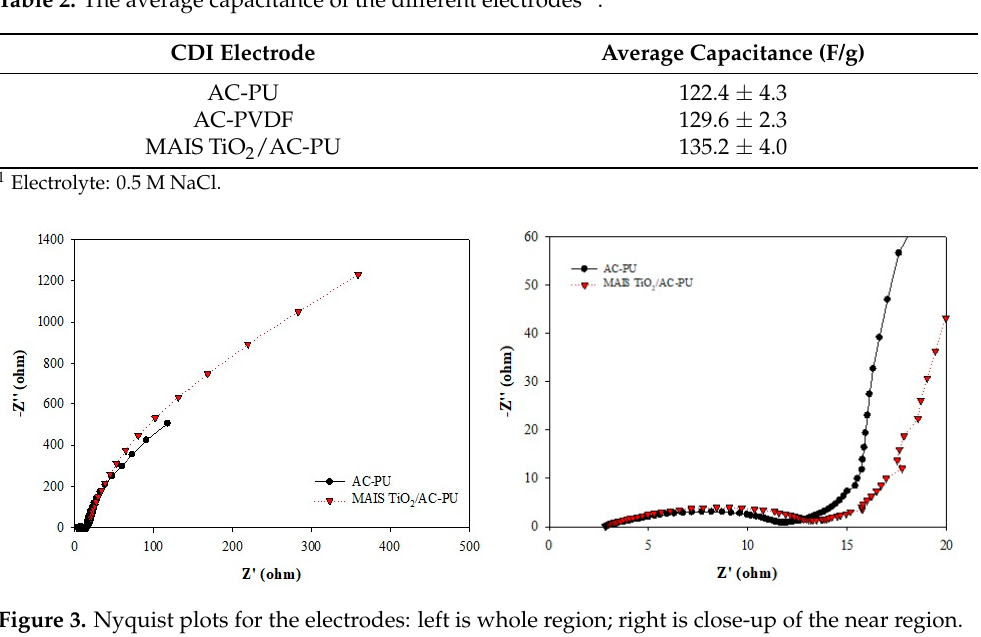
Figure 3. Nyquist plots for the electrodes: left is whole region; right is close-up of the near region.